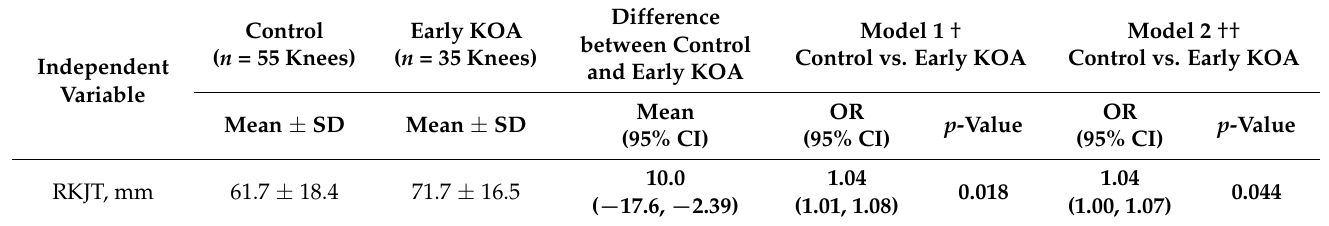
Table 2. Results of a binary logistic regression analysis investigating the relationship between